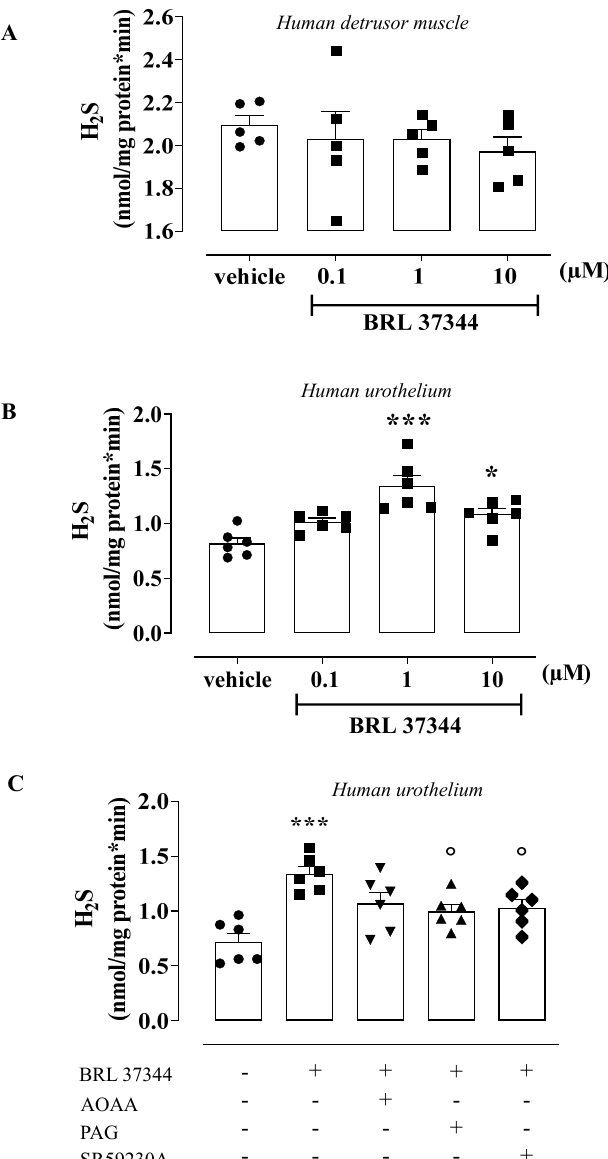
Figure 3. Effect of BRL 37344 on H 2 S production in the human bladder. ( A ) BRL 37344 (0.1–10 µM) did not modify the H 2 S rate of production compared to vehicle in human detrusor muscle. ( B ) BRL 37344 at 1 and 10 µM increased the H 2 S rate of production 1.7 and 1.4 times, respectively, compared to vehicle in the human urothelium (*** p < 0.001 and * p < 0.05). ( C ) PAG (10 mM) and SR59230A (10 µM) reduced BRL 37344 (1 µM)-induced H 2 S production 0.7-fold in the human urothelium (*** p < 0.001 vs. vehicle; ° p < 0.05 vs. BRL 37344); AOAA (1 mM) did not affect the BRL 37344-induced effect.